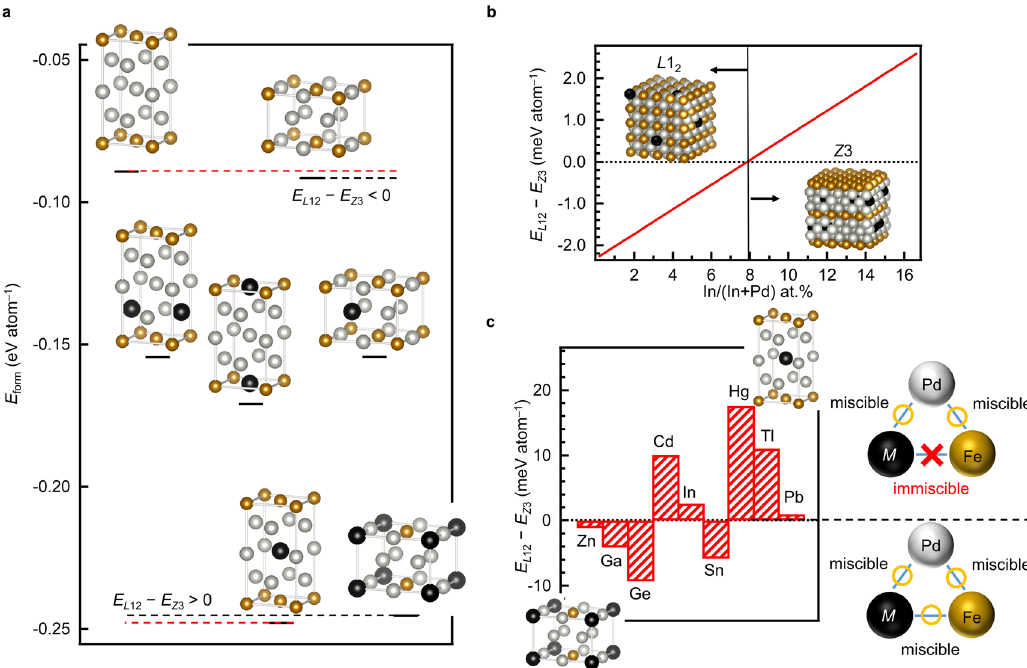
Fig. 3 Formation energies of Z 3-type versus L 1 2 -type structures. a Formation energies of Z 3-type and L 1 2 -type phases ( E form ) with In atoms in different sites. b , In composition-dependent formation energy difference between Z 3-Fe 2 (Pd 6- x ,In x d ) and L 1 2 -(Fe 2- x ,In x )Pd 6 (0 ≤ x ≤ 1) ( E Z 3 and E L 12 , respectively) phases, where 16.67 of In/(In + Pd) at.% corresponds to x = 1. c , Formation energies of most stable Z 3-Fe 2 (Pd 5 , M 1 d ) versus most stable L 1 2 -(Fe 1 , M 1 )Pd 6 in each crystal structure with the 12 – 14 groups additional-metallic element ( M ). Only when adding the elements M immiscible with Fe, was the Z 3-type structure more stable than the L 1 2 -type structure.